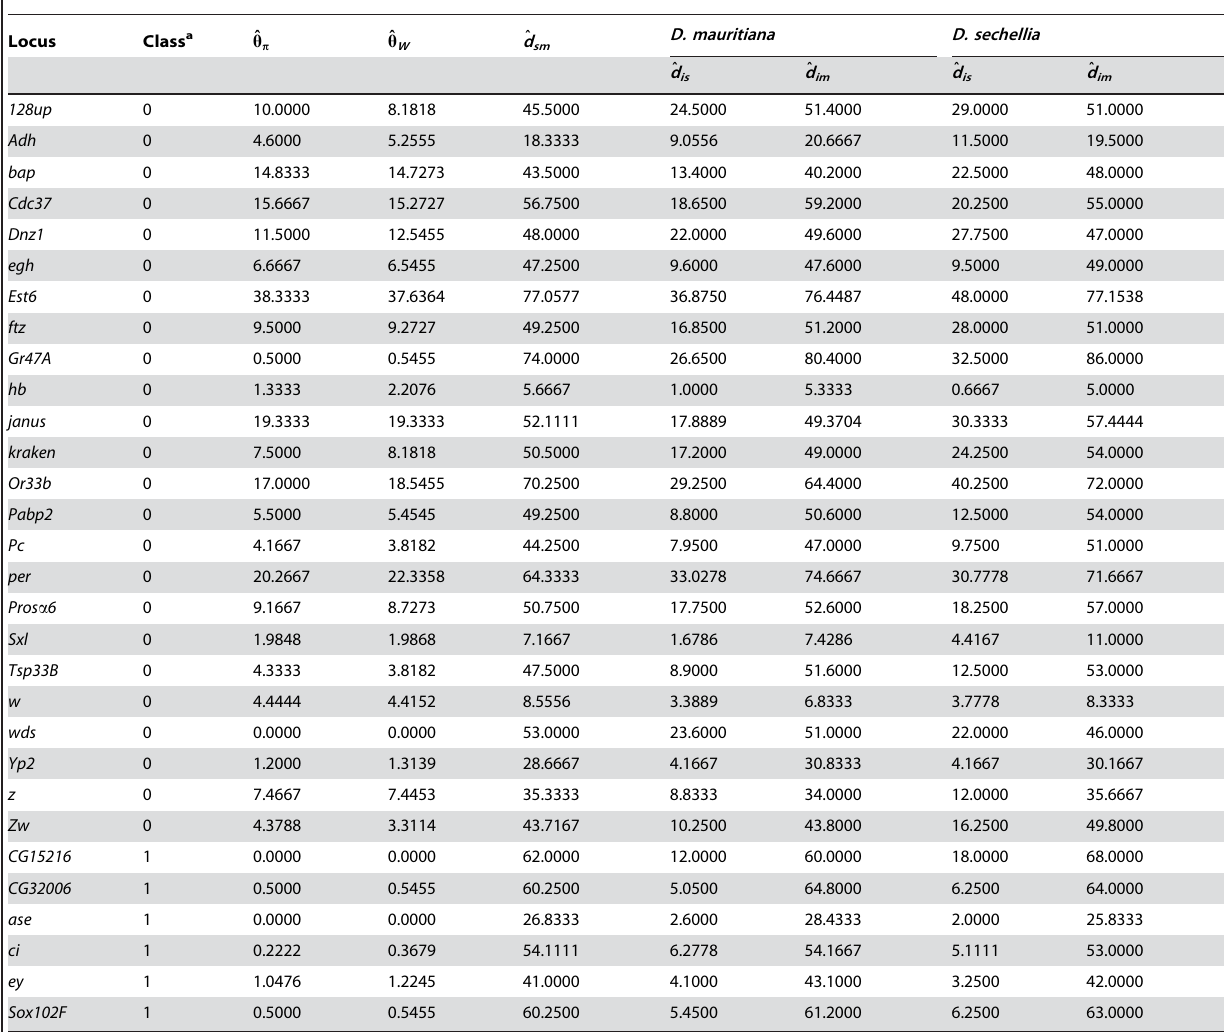
Table 2. Divergence and Drosophila simulans polymorphism.